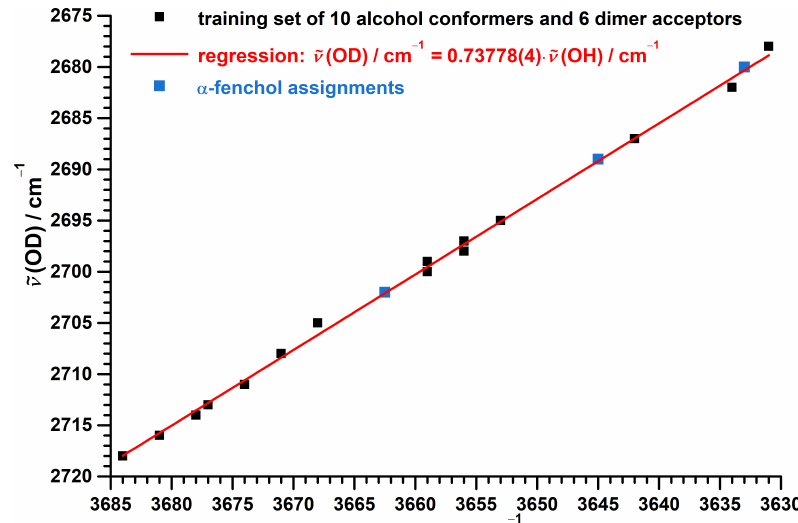
Figure 7. Correlation between experimental jet OD and OH stretching fundamental wavenumbers of alcohol monomers and alcohol dimer acceptors. Used data [75–77,92] for the training set are listed in Table S3. The linear regression for the training set uses a fixed intercept of